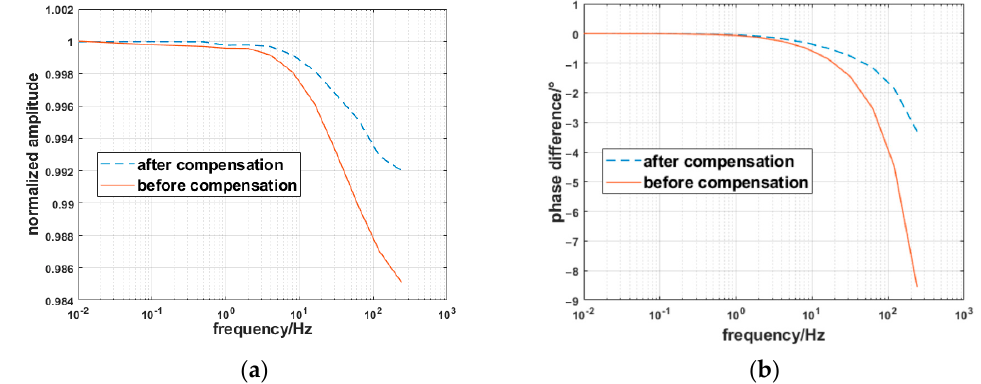
Figure 15. Amplitude/phase–frequency response curves of the fluxgate magnetometer before/after